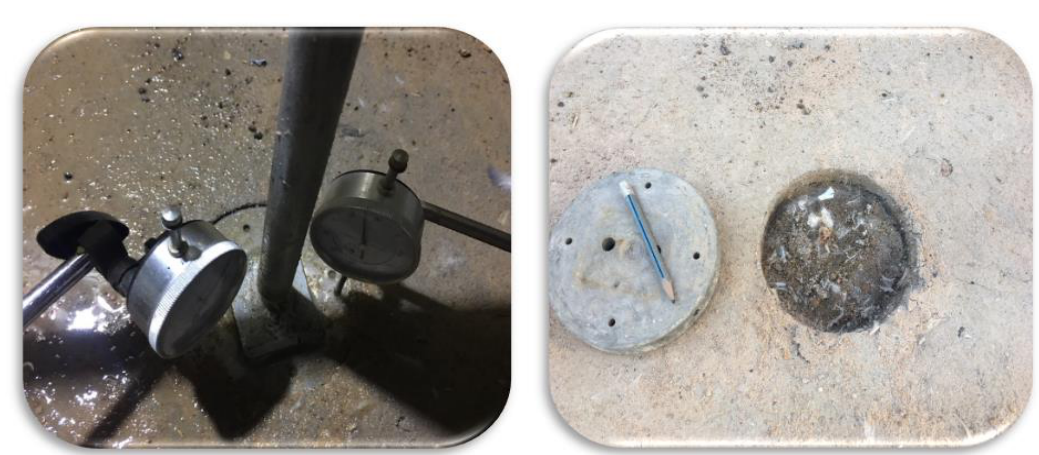
Fig. 8. Failure shape of the treated soil loaded in soaked state.